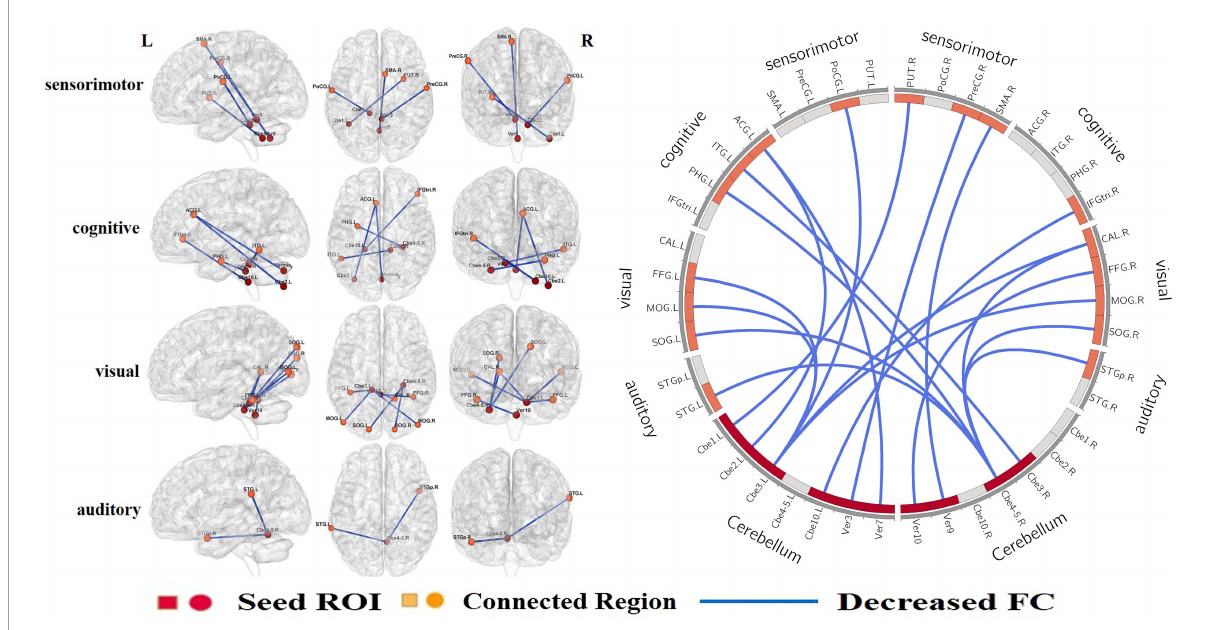
FIGURE2 When all the cerebellar subregions were defined as ROIs, CTSCI patients showed significantly decreased FCs in the sensorimotor-, visual-, cognitive-, and auditory-related regions. ROI, regions of interests; CTSCI, complete thoracolumbar spinal cord injury; FC, functional connectivity; Cbe, cerebellum; Ver, vermis; PUT, Putamen; ACG, anterior cingulate gyrus; CAL, calcarine; FFG, fusiform; MOG, middle occipital gyrus; PoCG, postcentral gyrus; ITG, inferior temporal gyrus; SOG, supra-occipital gyrus; PHG, parahippocampal gyrus; STGp, superior temporal pole; STG, superior temporal gyrus; IFGtri, trigonometric inferior frontal gyrus; PreCG, precentral gyrus; SMA, supplementary motor area; R, right; L, left.